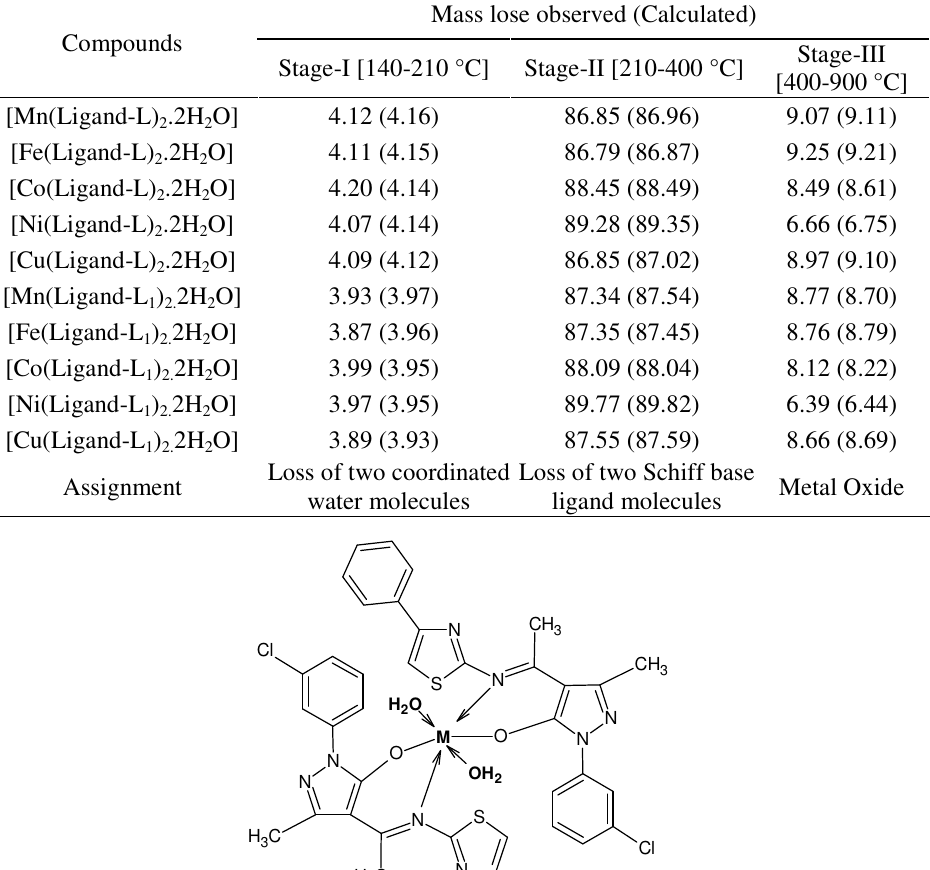
Table 2. Thermo analytical results of ligands and its metal complexes (control-DMF)